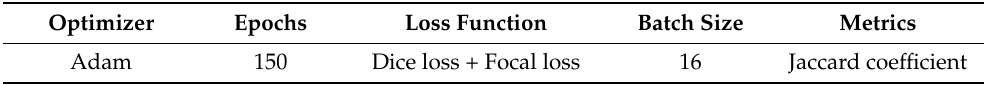
Table 1. Parameters for training the U-net segmentation models.